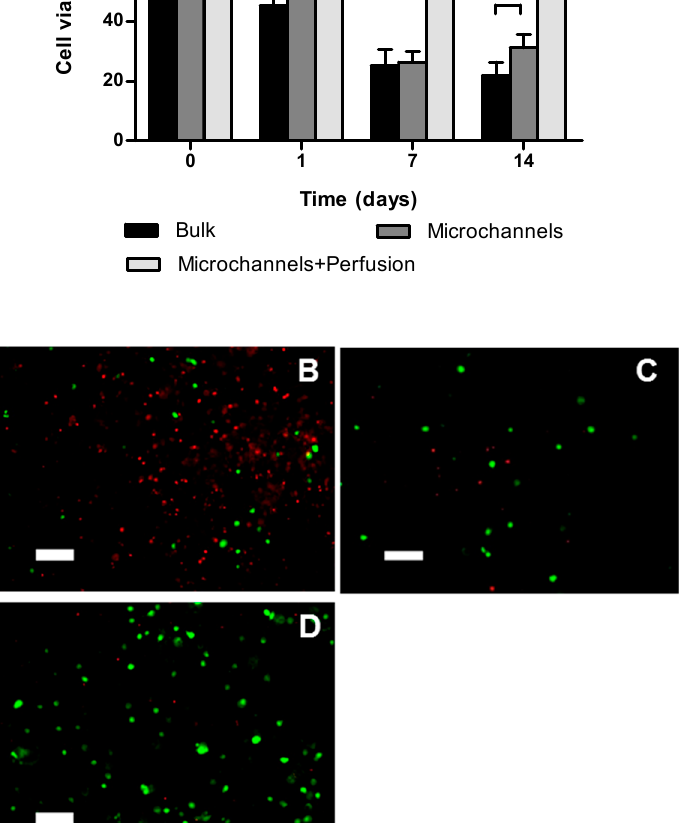
Figure 4. Cell viability at the geometric center of Si-HPMC 2% constructs 9 × 9 × 4 mm 3 (length × width × height) seeded with 8 million cells / mL was assessed with Live / Dead assay using confocal microscopy. ( A ) Cell viability at 0, 1, 7, and 14 days after bioprinting. Values are mean ± SEM ( n = 3). ( B – D ): Confocal microscopy images of Live (green) and Dead (red) cells in the center of the constructs 14 days after bioprinting ( B : Bulk construct; C : with microchannels; D : with microchannels and perfusion). scale bar = 100 µ m. * p < 0.05; *** p <